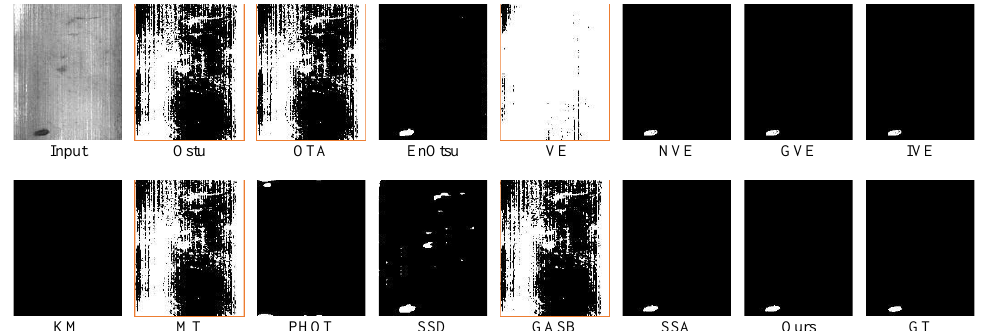
Figure 7. Result of different methods on magnetic tile images with a blowhole defect. Visual comparisons of detection results of the fourteen methods on magnetic tile images witha blowhole defect. EnOstu, NVE, GVE, IVE, SSA, and the proposed method (ours) are capable of identifying the defect location.